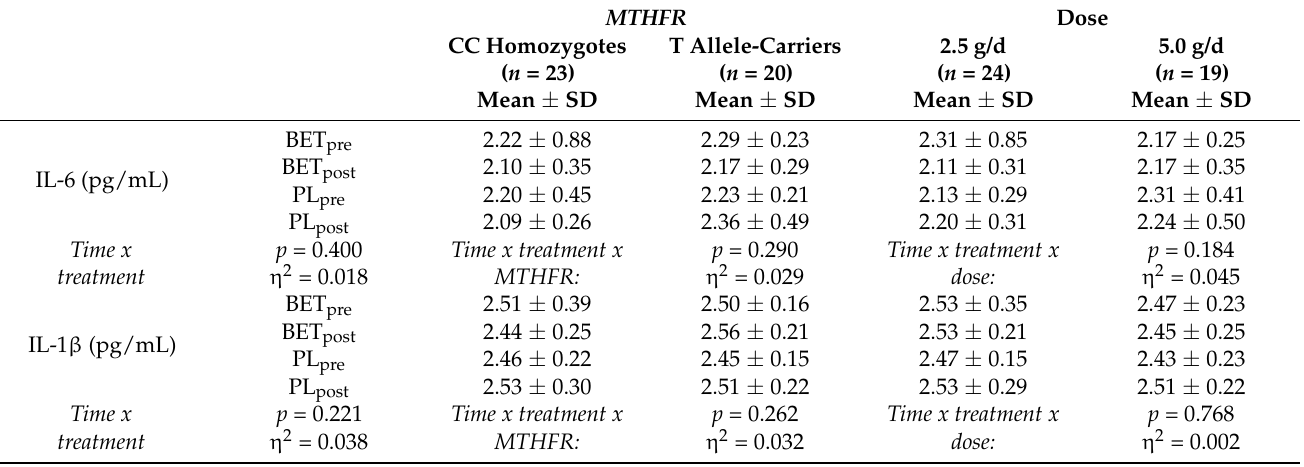
Table 5. The effect of betaine supplementation on the concentrations of cytokines in relation to MTHFR genotype and BET dose.